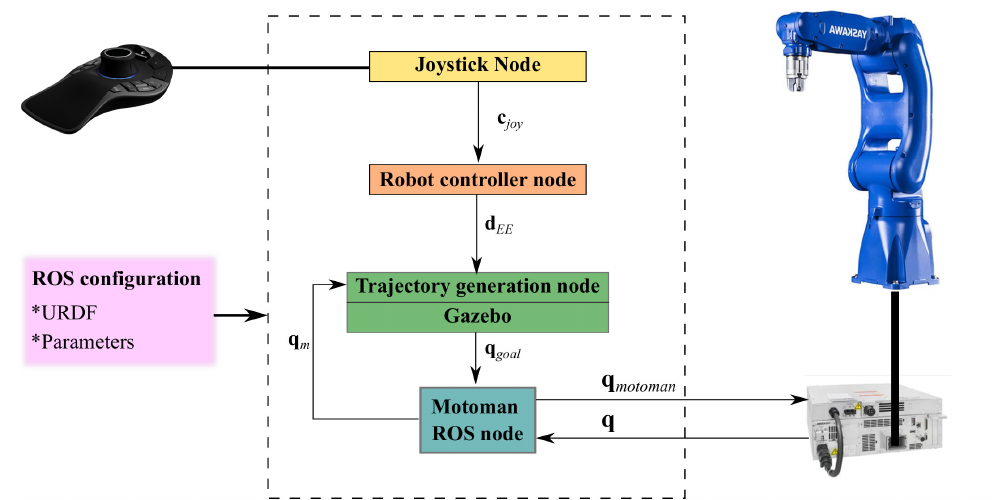
Figure 1. Control architecture of a robot teleoperated by a